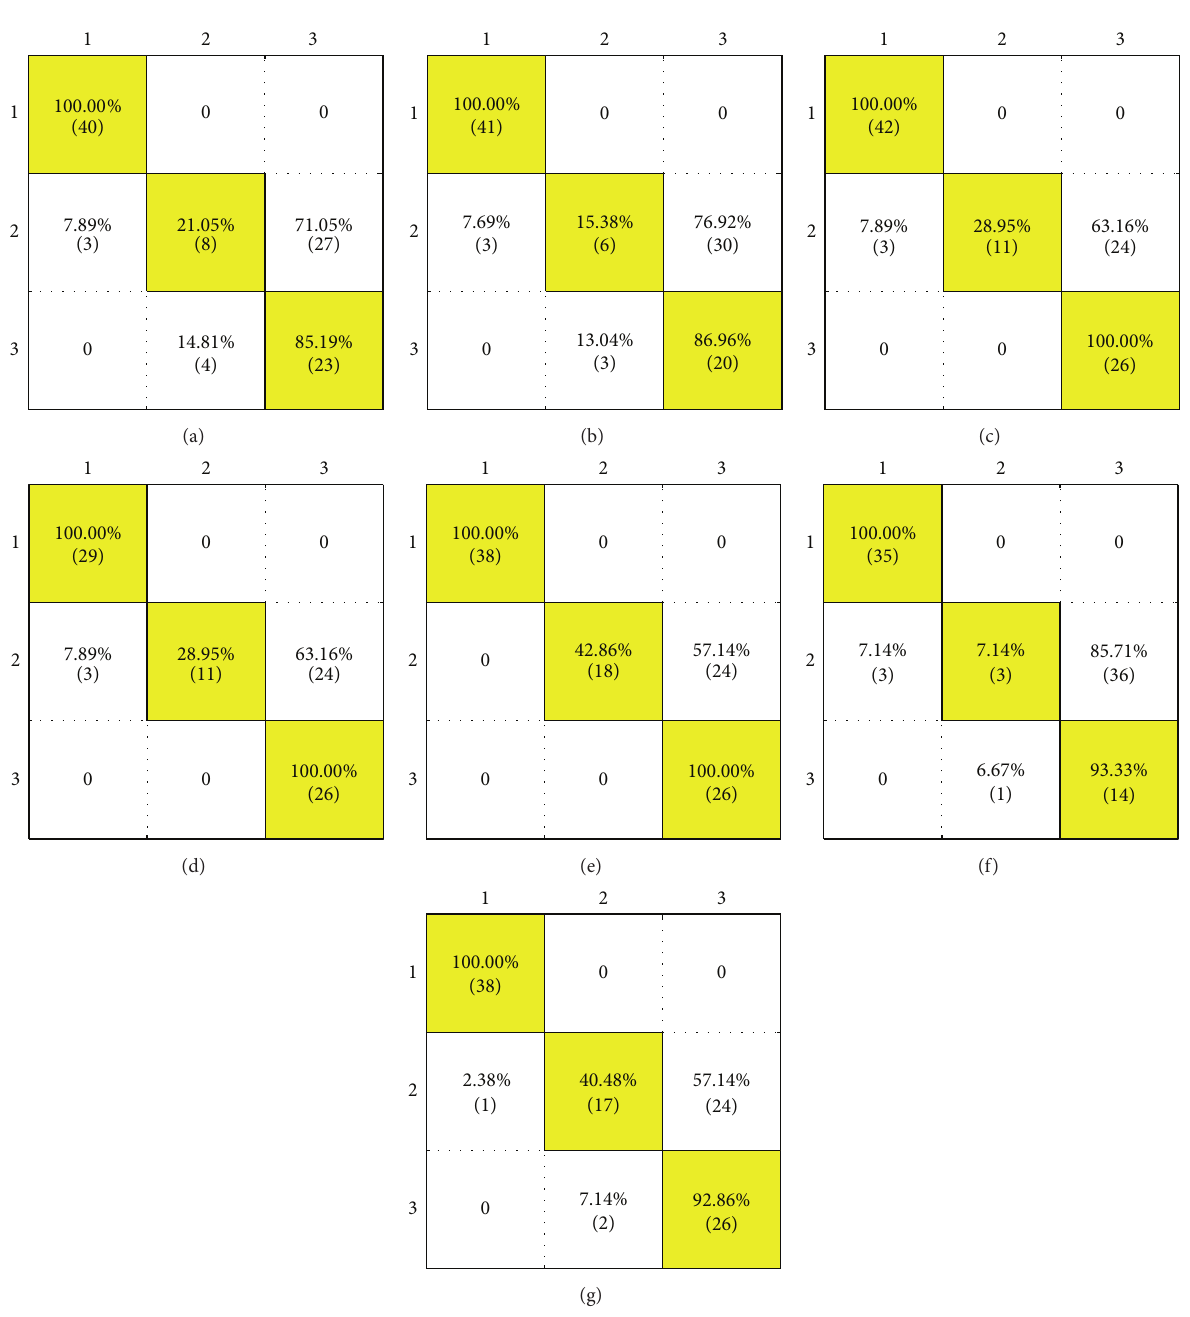
Figure 8: Confusion matrix obtained with ASClass on Iris dataset for 100 iterations. (a) 𝑚 = 5 ; (b) 𝑚 = 10 ; (c) 𝑚 = 20 ; (d) 𝑚 = 30 ; (e) 𝑚 = 40 ; (f) 𝑚 = 50 ; (g) 𝑚 = 100